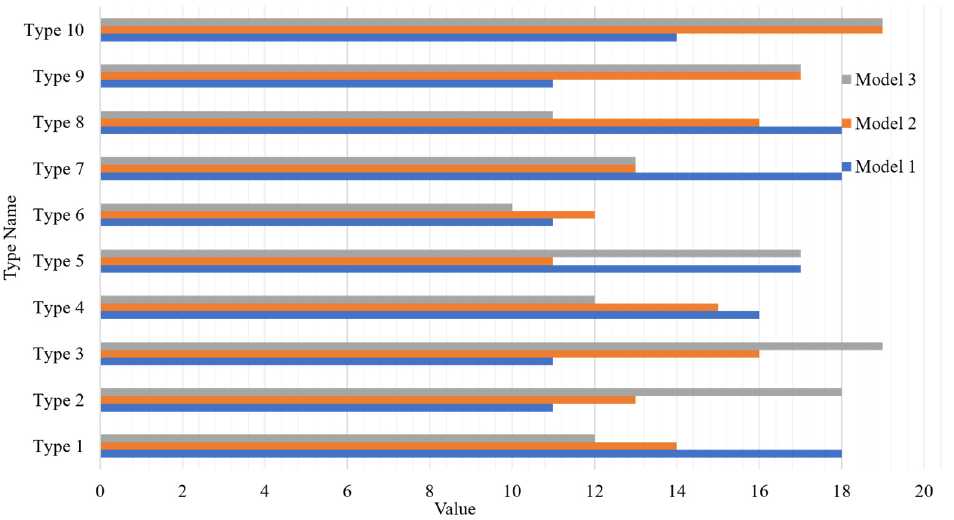
Figure 5. Schematic diagram of big data analysis of scenic spots.